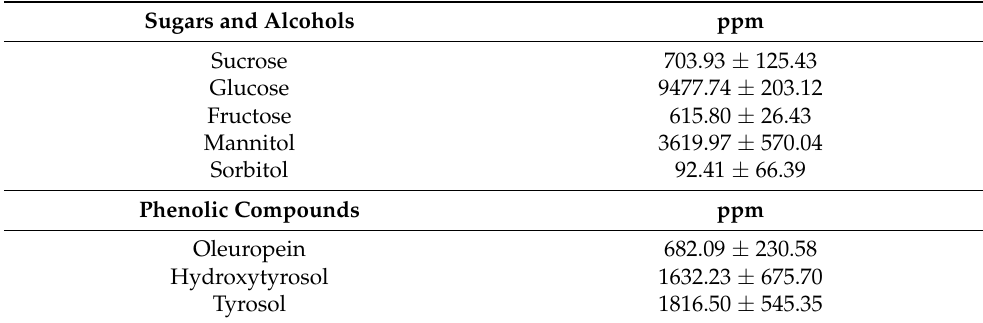
Table 1. Sugar, alcohol and polyphenol content in the raw olive pulp. Data are the average from the three replicates ± standard